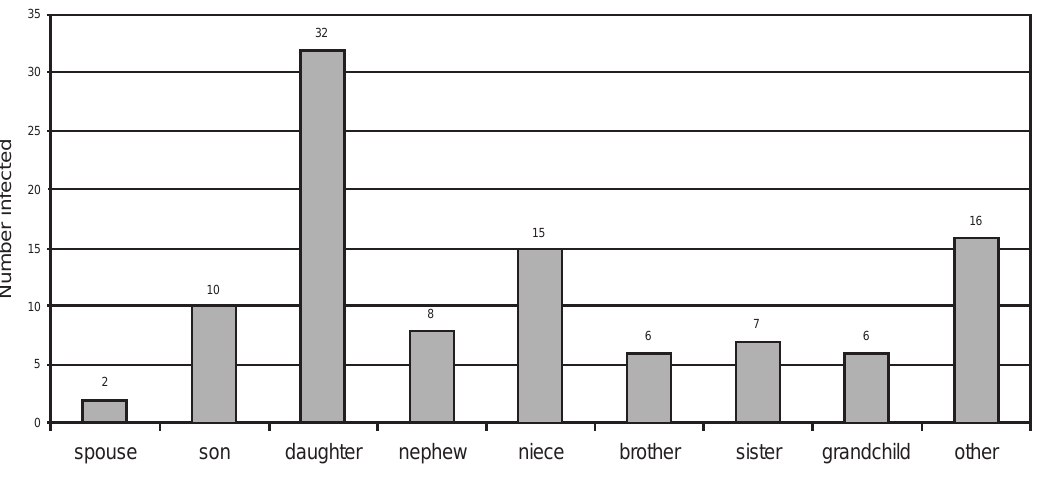
Fig. 3. Grandmothers’ family members who were HIV